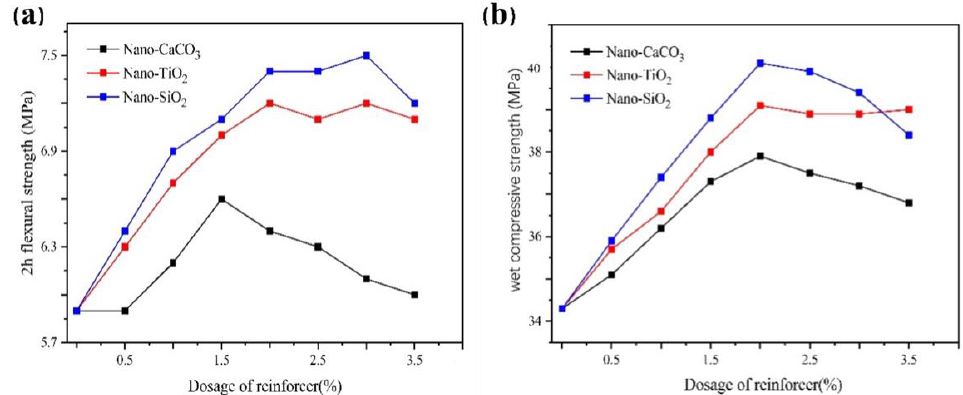
Figure 9. The effect of inorganic nano-materials on the mechanical strength of dental gypsum at different dosages (ww − 1 ) ( a ) 2 h flexural strength, ( b ) wet compressive strength.